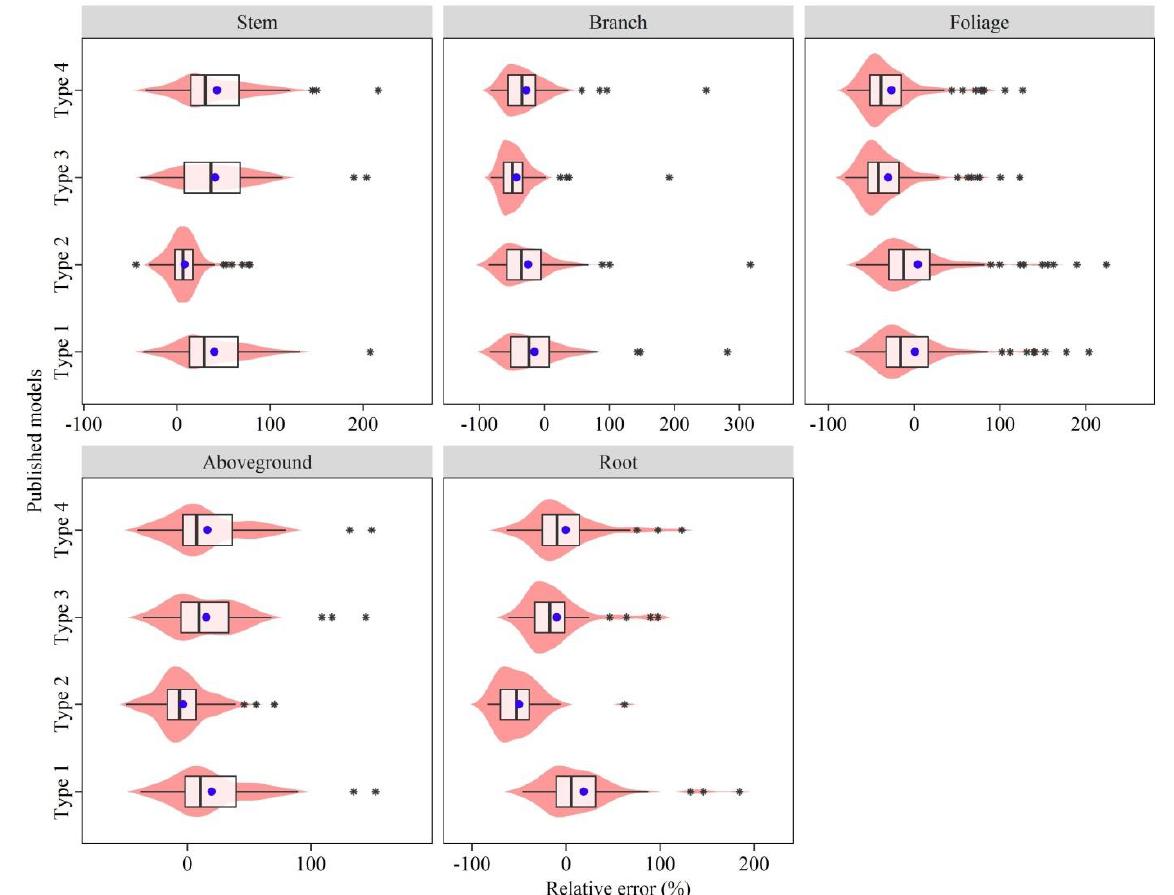
Figure 9. Distributions of the relative error of published Mongolian oak biomass models. The length of the box indicates the 25th – 75th percentile, the horizontal lines attached to the box represent the smallest and maximum values, the dot inside the box represents the mean value, the horizontal line inside the box represents the median and outliers are marked as asterisks. The violin represents a probability density.